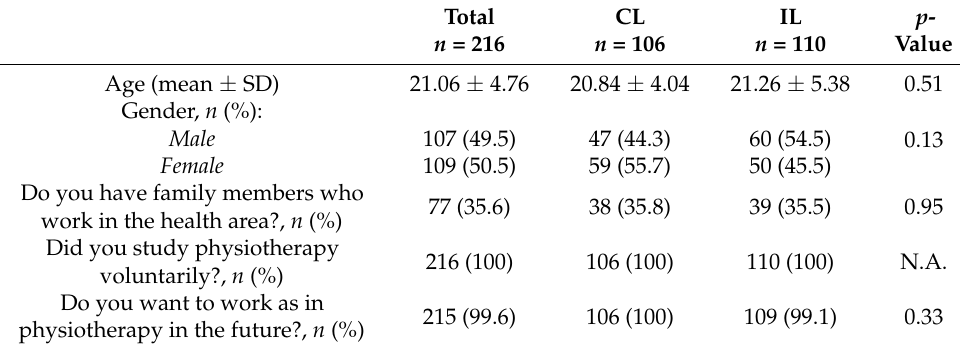
Figure 1. Flow diagram of study participation. Table 1. Sociodemographic characteristics of the sample.